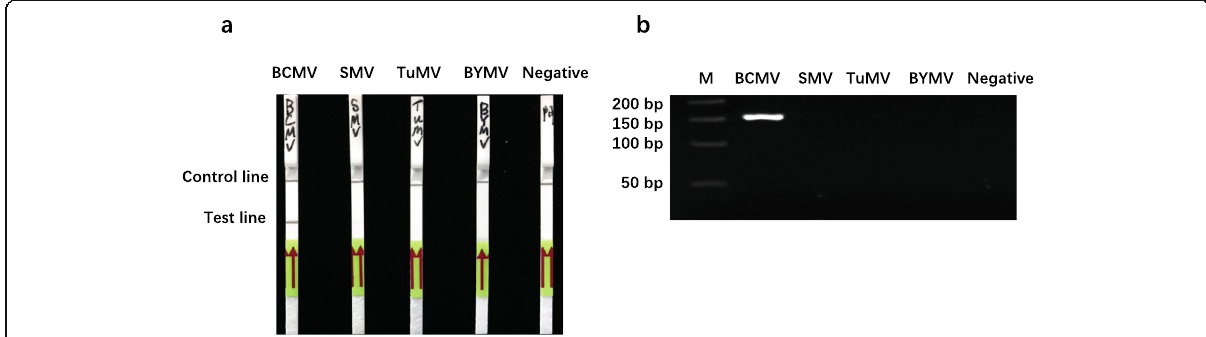
Fig. 3 Specificity of RPA-LFD assay for BCMV detection. a BCMV, SMV, TuMV and BYMV samples were detected by RPA-LFD assay using BCMV- specific primers and probe. b BCMV, SMV, TuMV and BYMV samples were detected by PCR using BCMV-CP primers. In RPA-LFD and PCR assays,